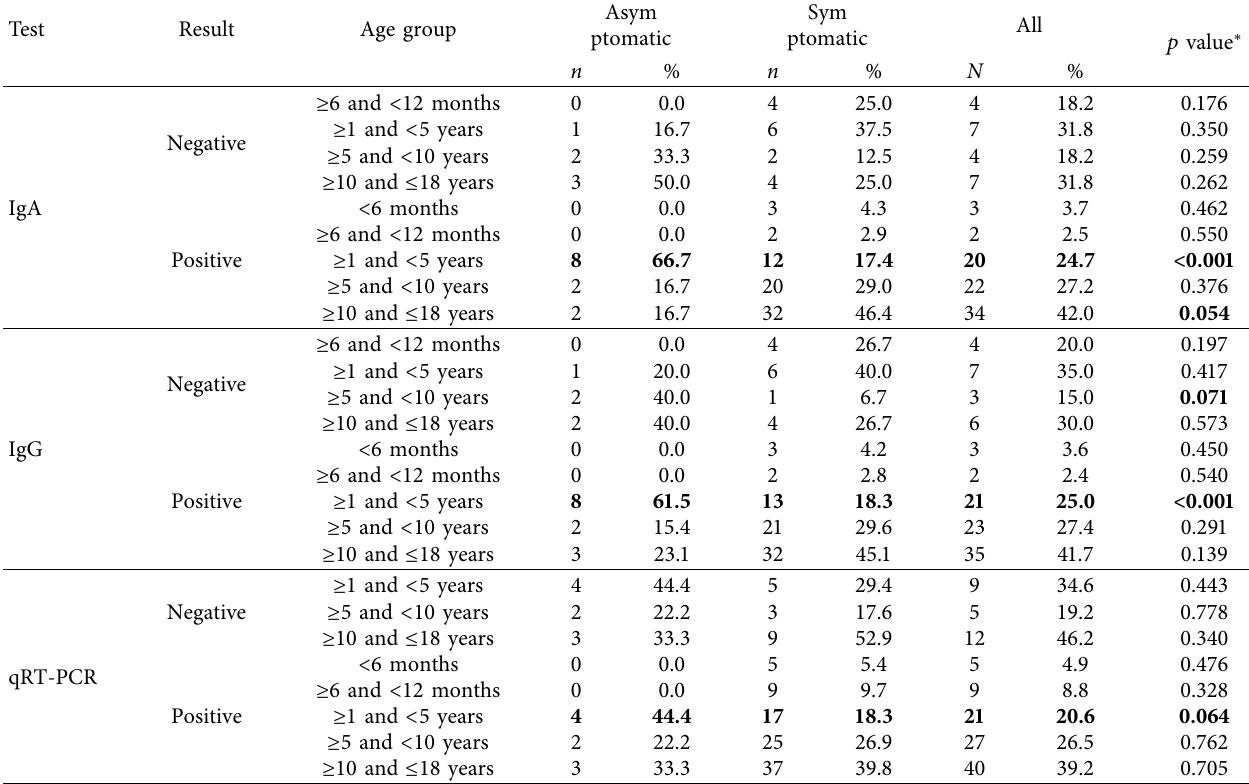
Table 4: Correlation between presence of symptoms and laboratory confirmation of SARS-CoV-2 infection in 128 children and adolescents by age group.